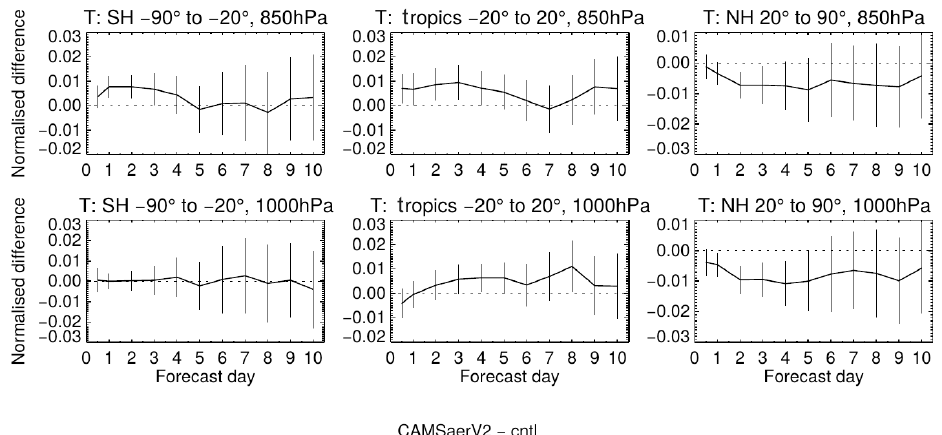
Figure 11. Normalised temperature RMSE difference at 1000 and 850hPa for a set of forecast runs using the new CAMS climatology against the operational configuration. The experiments cover a summer season (2 May to 13 August 2016) and are verified against the operational analysis. Confidence range of 95% with AR(2) inflation and Sidak correction for four independent tests (Geer, 2016). These experiments were done using a cubic-octahedral spectral truncation TCo399, but the main results are independent on the model resolution. Values < 0 mean that the forecasts with the CAMS climatology are better than those with the TG97